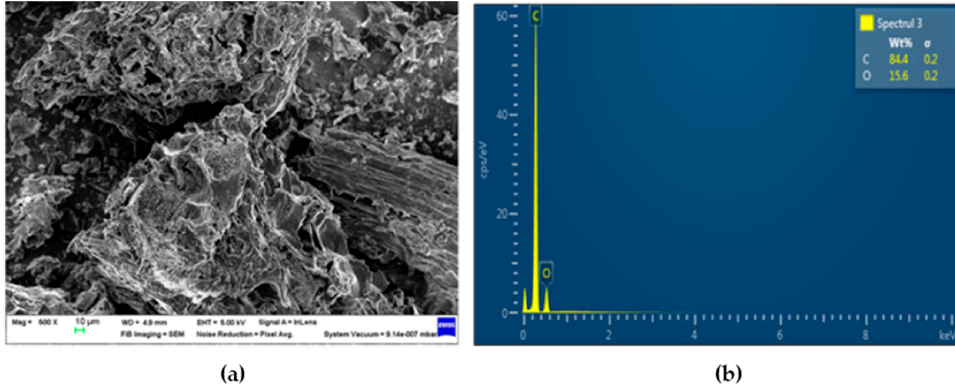
Figure 3. SEM image of Hc ( a ) and corresponding elemental chemical analysis, EDX ( b ).